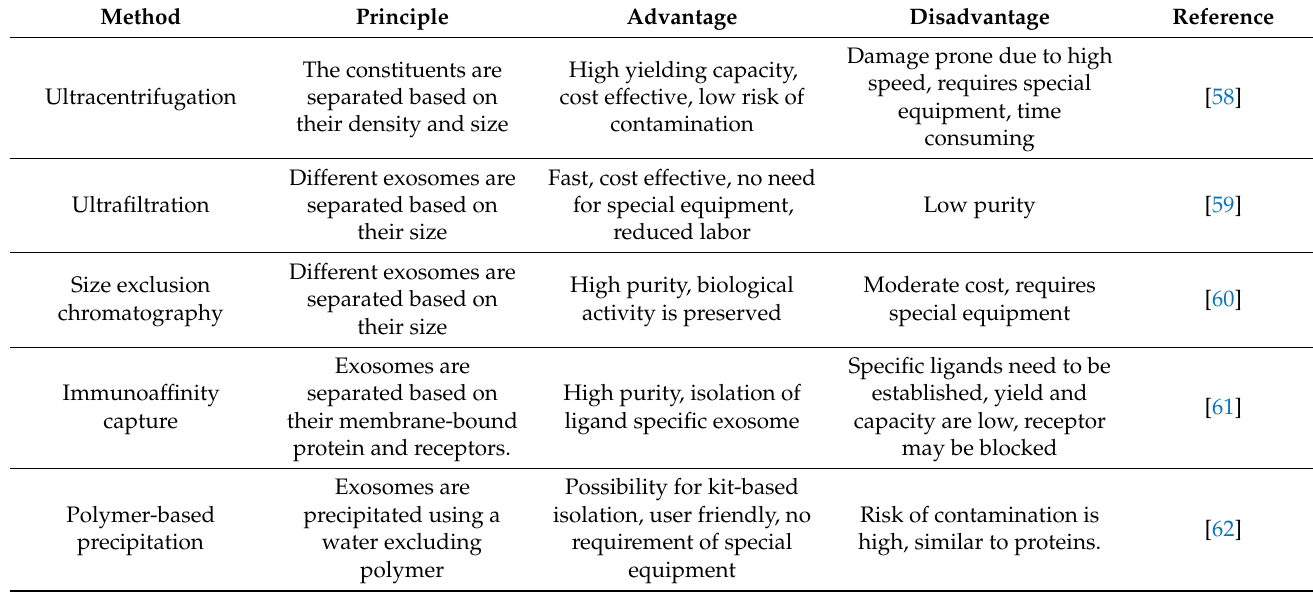
Table 1. Methods of exosome isolation: different methods of exosome isolation along with their advantages and disadvantages.